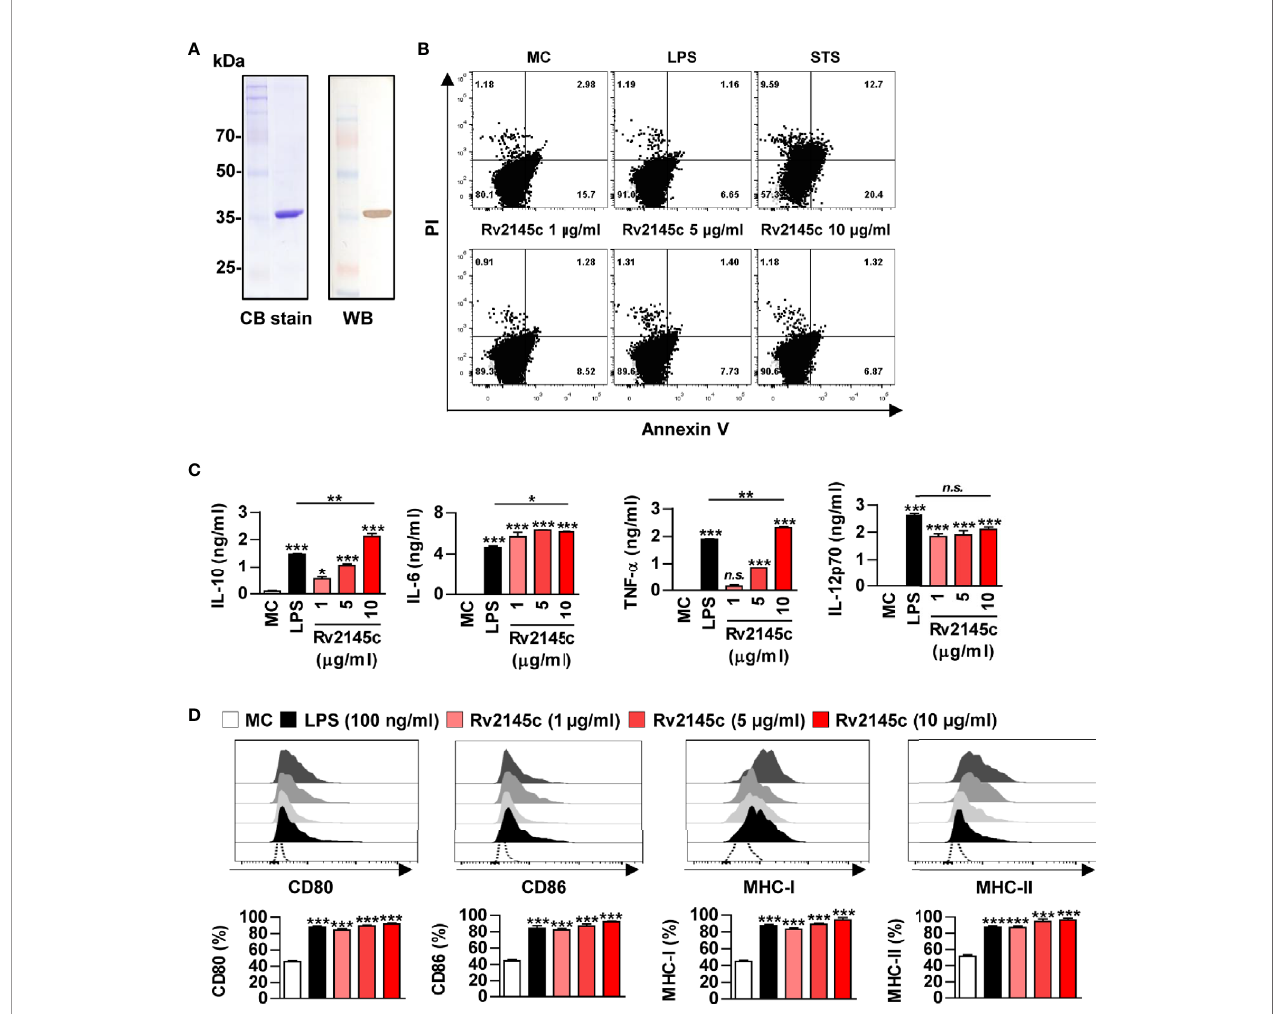
FIGURE 1 | Recombinant Rv2145c induces macrophage activation. (A) Rv2145c puri fi ed from E coli extracts was analyzed by SDS-PAGE with Coomassie blue staining and immunoblot staining using an anti-His antibody. (B) The cytotoxic effects of Rv2145c were analyzed by fl ow cytometry. BMDMs were stimulated with Rv2145c (1, 5 or 10 m g/ml), LPS (100 ng/ml) or staurosporine (STS, 100 nM) for 24 h and then stained with Annexin V and PI. The percentage of positive cells in each quadrant is indicated. (C, D) BMDMs were stimulated with Rv2145c (1, 5 or 10 m g/ml) or LPS (100 ng/ml) for 24 h. IL-10, IL-6, TNF- a , and IL-12p70 levels in the culture supernatants were measured by ELISA (C) . The expression of surface markers was analyzed by two-color fl ow cytometry (D) . The cells were gated to exclude F4/80 + cells. BMDMs were stained with anti-CD80, anti-CD86, anti-MHC class I or anti-MHC class II antibodies. The bar graphs show the percentage (mean ± SD of three experiments) for each surface molecule on F4/80 + cells. All data are representative of three experiments. * p < 0.05, ** p < 0.01, and *** p < 0.001 for treatment compared with medium controls (MC) or for the difference between treatment data. n.s., no signi fi cant